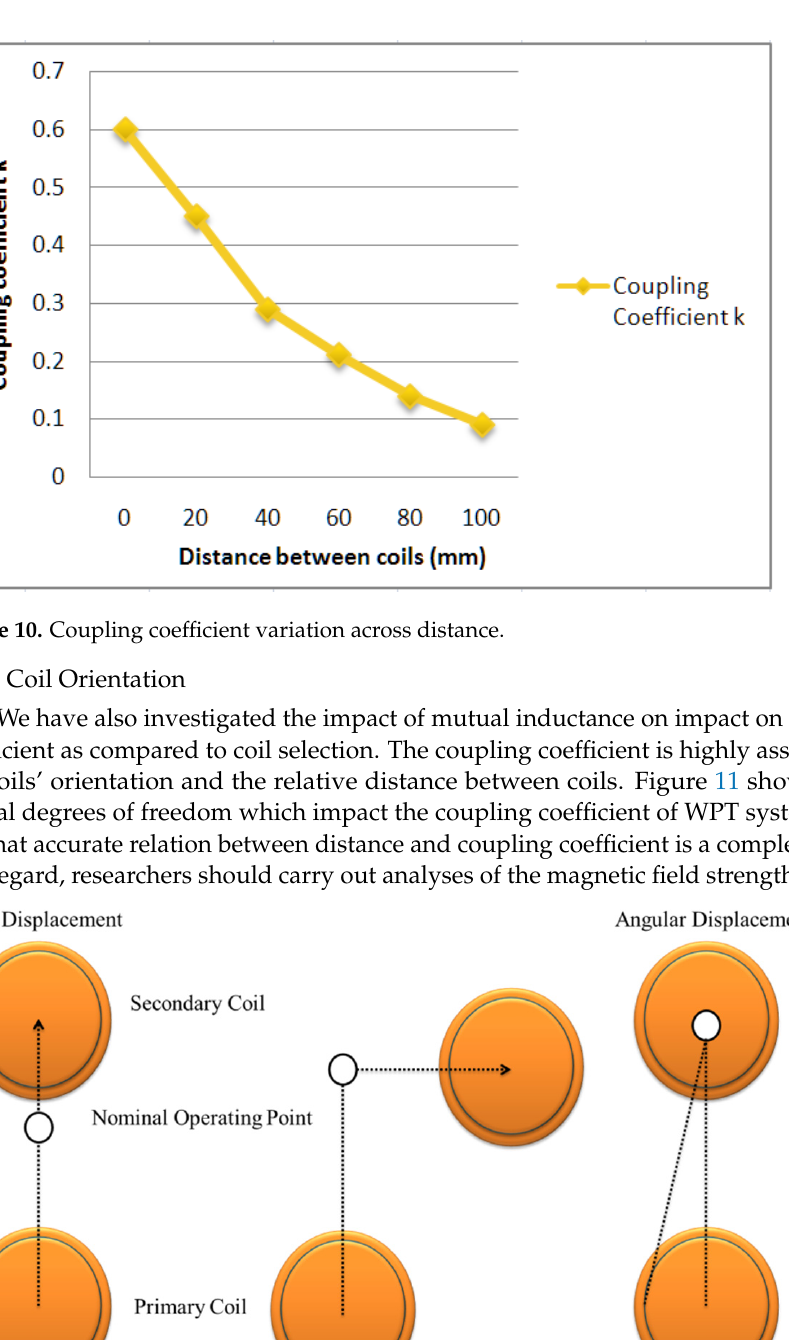
( h ) Figure 12. IWPT systems using coils investigated by: ( a ) Askari et al. [78]; ( b ) James et al. [79]; ( c ) Santos et al. [82]; ( d ) WiTricity [80]; ( e , f ) Shi et al. [83]; ( g ) Bana et al. [85]; and ( h ) He et al. [100]. We have investigated the effect of coil size, shape, orientation and coupling coeffi- cient. Besides these, another important factor is coil winding or number of turns which has a great impact on an efficient coupling [40]. Considering coils’ shape, distance and number of turns, we have noticed that the coupling coefficient of a spiral coil is higher than of a helix coil. In a recent study, Z. He et al. [100] demonstrated a three dimensional omnidirectional topology for underwater operations. In another study [101], X. Shi et al. stated that the efficiency of a spiral coil is better as compared to a helix coil as the distance between the coils increases. Surprisingly, the coupling coefficient for a helix coil de- creases while for spiral coil it increases by increasing the number of turns, as shown in Figure 13. Hence, the coupling coefficient is a key element for designing of any coil [41].